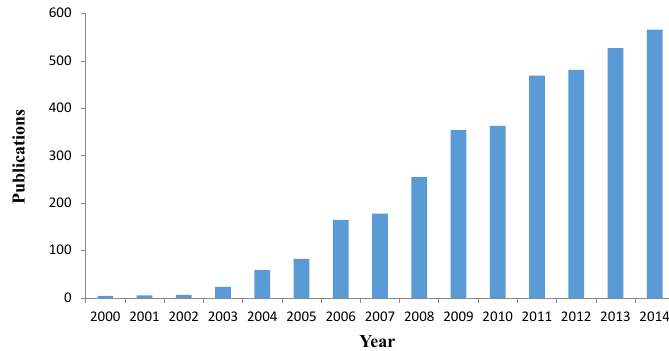
Figure 2. Number of publications on droplet microfluidics in the past 15 years.